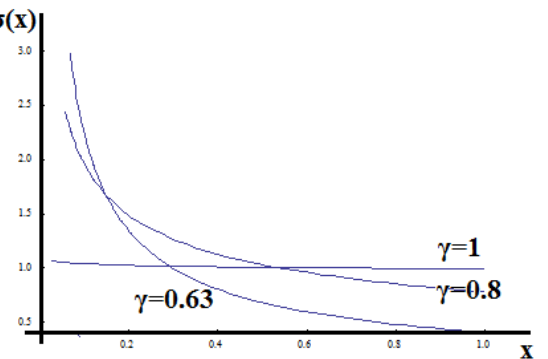
Figure 6. The non-dimensional stresses along the x -axis of the bar.